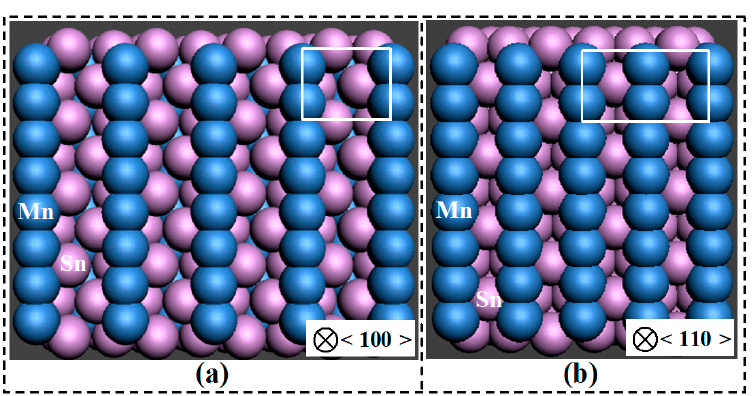
Figure 3. 3D atomic structures of the ( a ) {100} and ( b ) {110} planes of the MnSn 2 phase. The rectangular frames enclose a unit cell in ( a , b ), respectively.